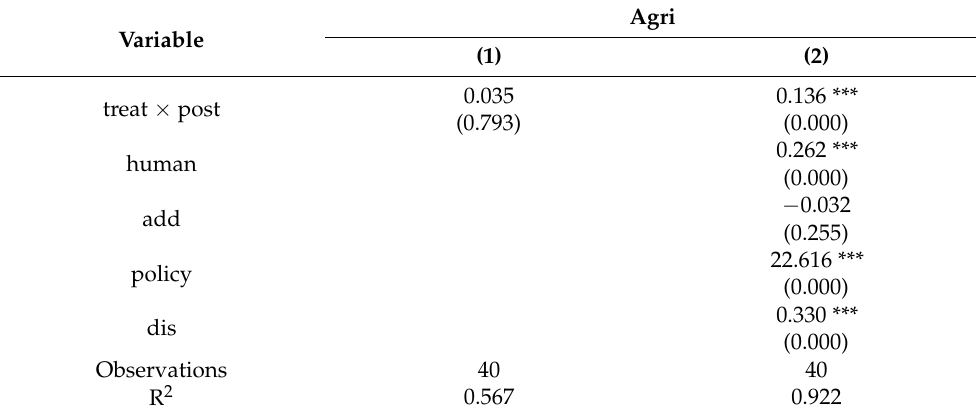
Table 11. Regression results of DID between broadband construction and agricultural green